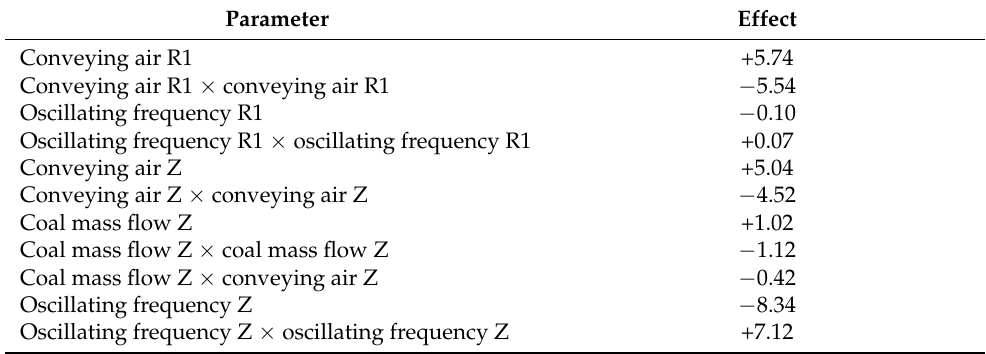
Table 2. Calculated effects of the parameters on the multiple regression model.